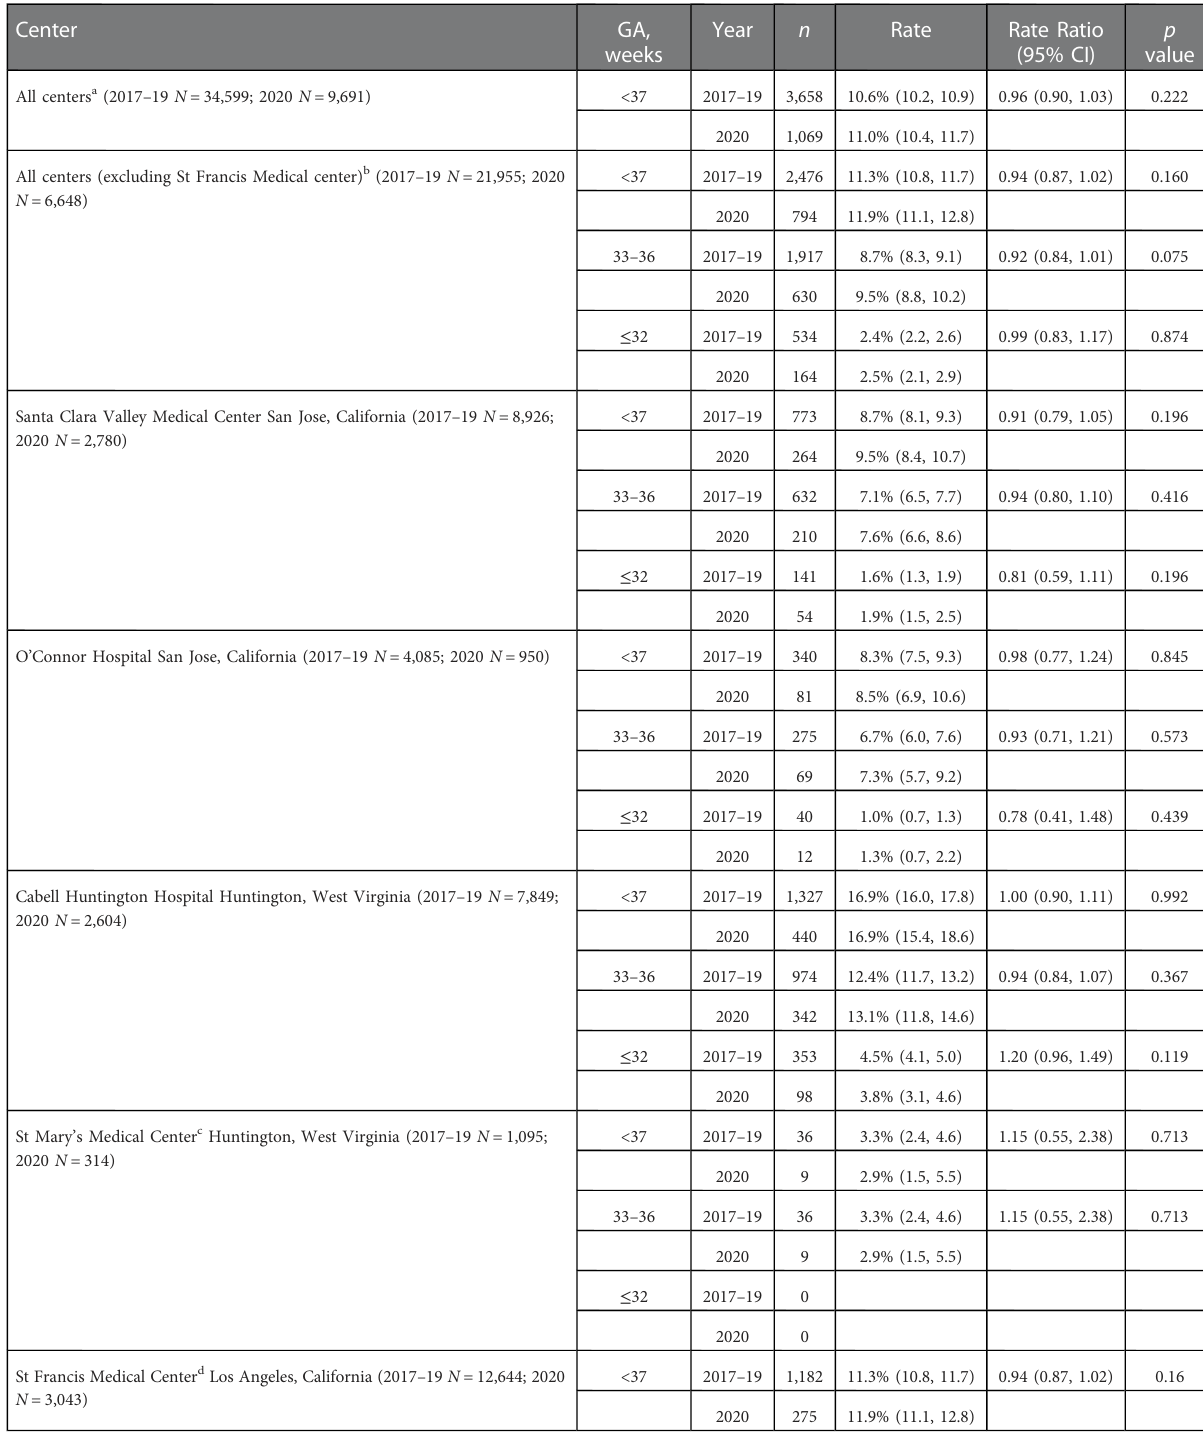
TABLE 1 Comparison of pre-COVID era (2017 – 2019) vs. COVID era (2020) preterm birth rates across fi ve medical centers strati fi ed by gestational age (GA).